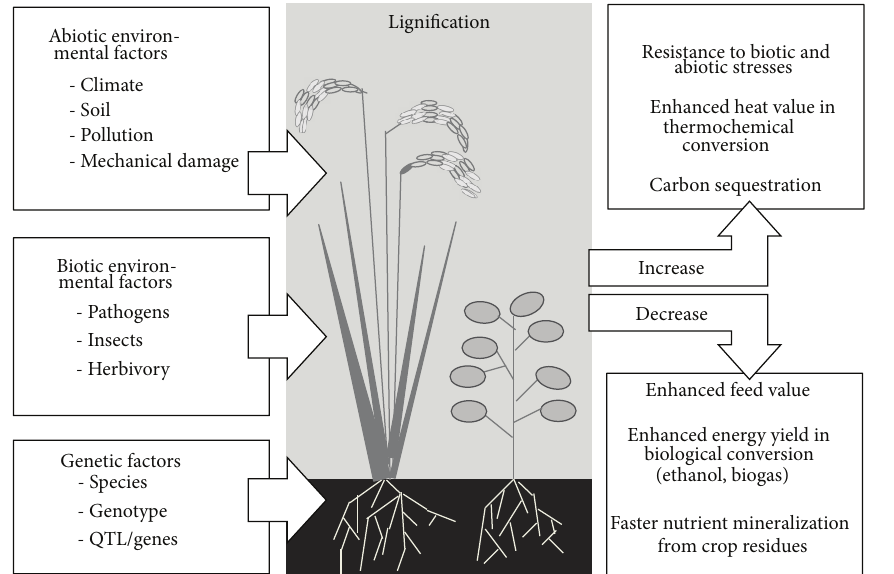
Figure 3: Conceptual model of factors influencing the lignification of crops and its implications for different agricultural